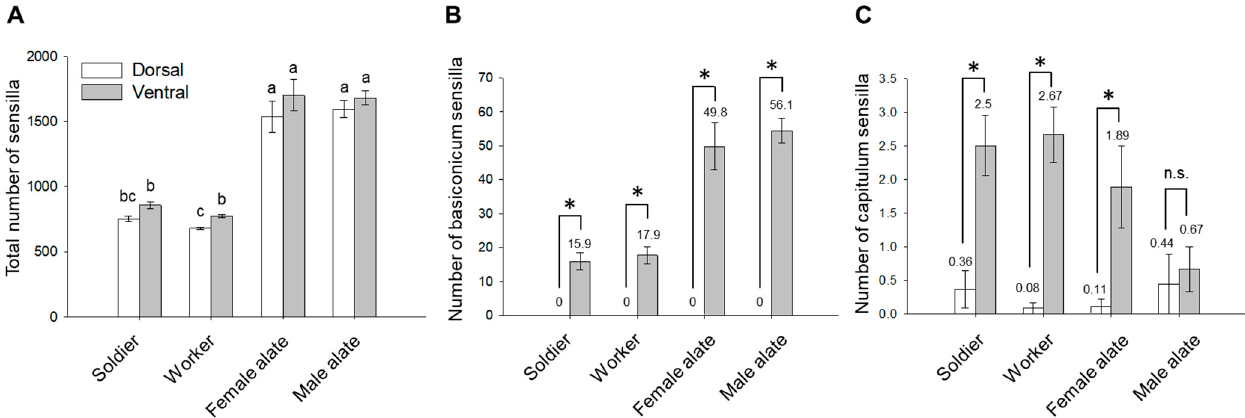
Figure 3. Dorsal and ventral distribution of antennal sensilla in C. formosanus castes. ( A ) Total number of sensilla on dorsal and ventral sides per antenna (mean ± SE). Groups denoted with the same letter are not significantly different ( p > 0.05, Kruskal–Wallis followed by pairwise Wilcoxon rank sum tests with Bonferroni correction). ( B , C ) show number of basiconicum and capitulum sensilla per antenna, respectively, distributed on each side. Means are presented above bars. Bars represent mean ± SE (*, p < 0.05; n.s., not significant, p > 0.05; Wilcoxon rank sum test). Dorsal side: n = 11, 12, 9, and 9 for soldier, worker, female and male alate, respectively; Ventral side: n = 12, 12, 9, and 9 for soldier, worker, female and male alate,